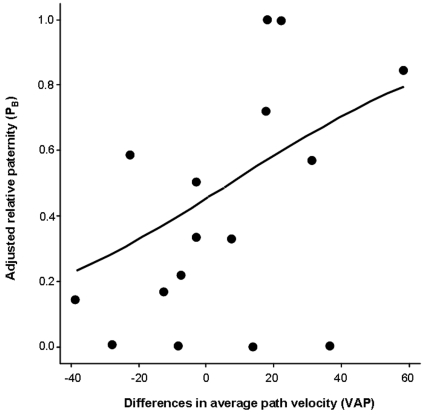
Fitted curve from a generalized linear model analysing the relationship between relative paternity (PB: proportion of offspring sired by the male arbitrarily labelled as B in each replicate) and sperm swimming velocity (VAP).